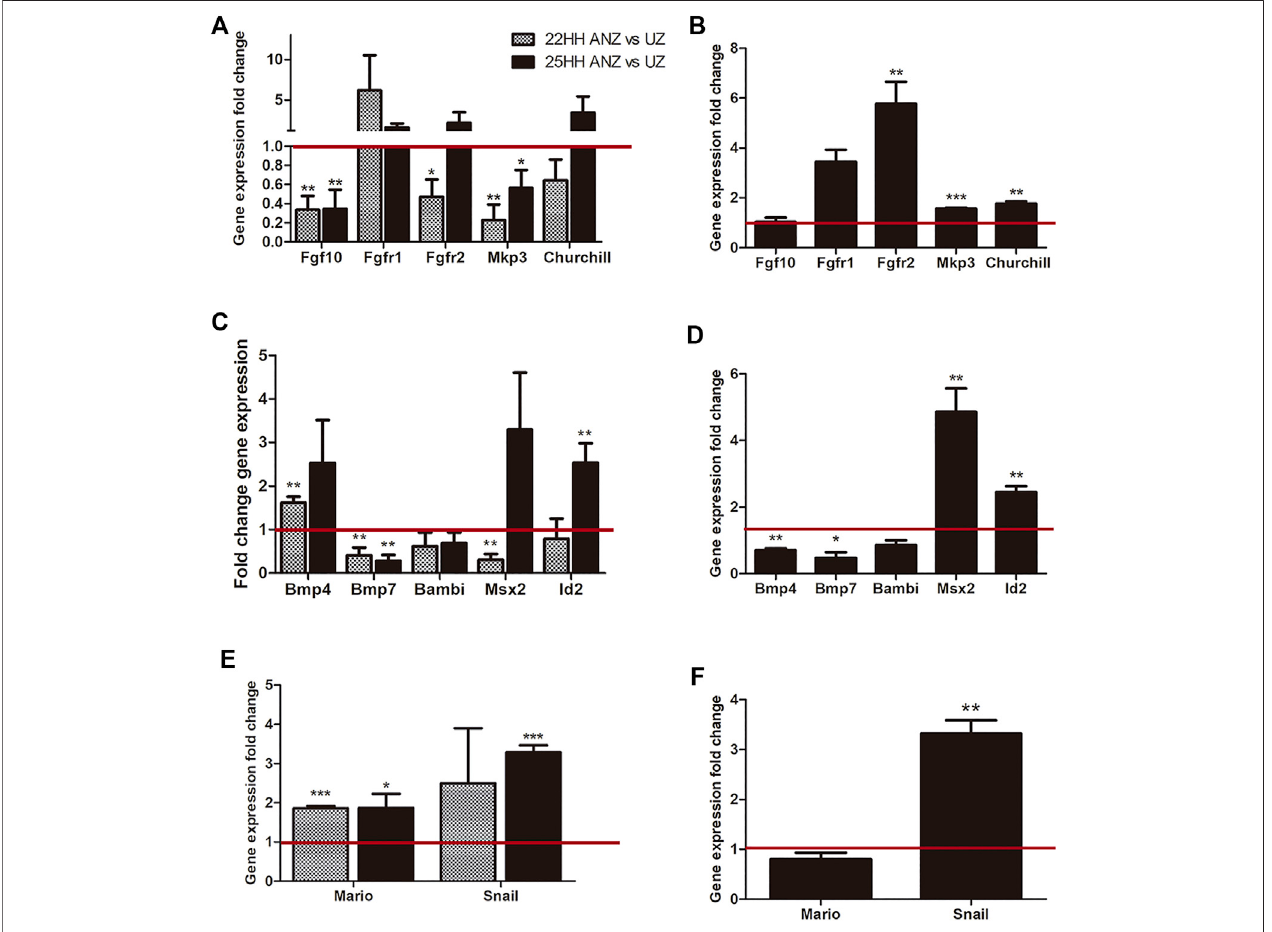
FIGURE7 | qRT-PCRanalysis and comparison dynamicsofgene expression in the presumptive ANZ and theANZ. qRT-PCR ofFGF-related genes(Fgf10, Fgfr1, Fgfr2,Mkp3,Churchill)andBMP-relatedgenes(Bmp4,Bmp7,Bambi,Mario,Snail). (A,C,E) ComparisonofgeneexpressionbetweenthepresumptiveANZin22HHvs its undifferentiated zone (UZ) and between the ANZ versus its UZ. (B, D, F) Analysis of gene expression in the ANZ at 25 HH stage relative to the presumptive ANZ at 22 HH stage (set to 1.0, red line). Data represent three independent experiments. Statistical signi fi cance was set as follows: *** p < 0.0001, ** p < 0.005, * p < 0.05.